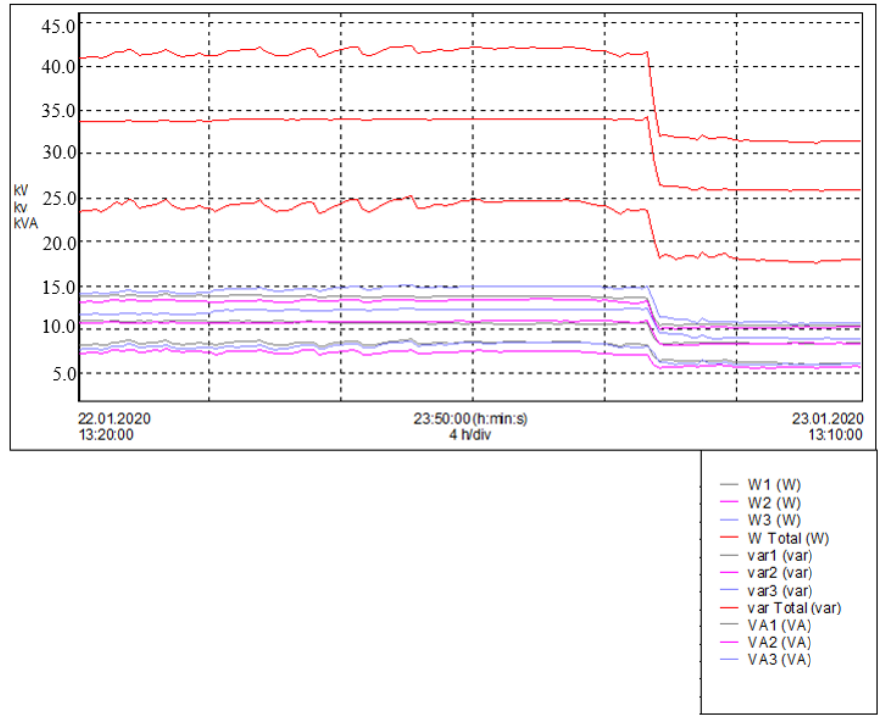
Figure 8. Daily load curves for TS1 electricity consumers.